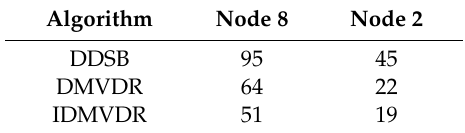
Table 4. The number of iterations when converging in the WASN with N d = 20.